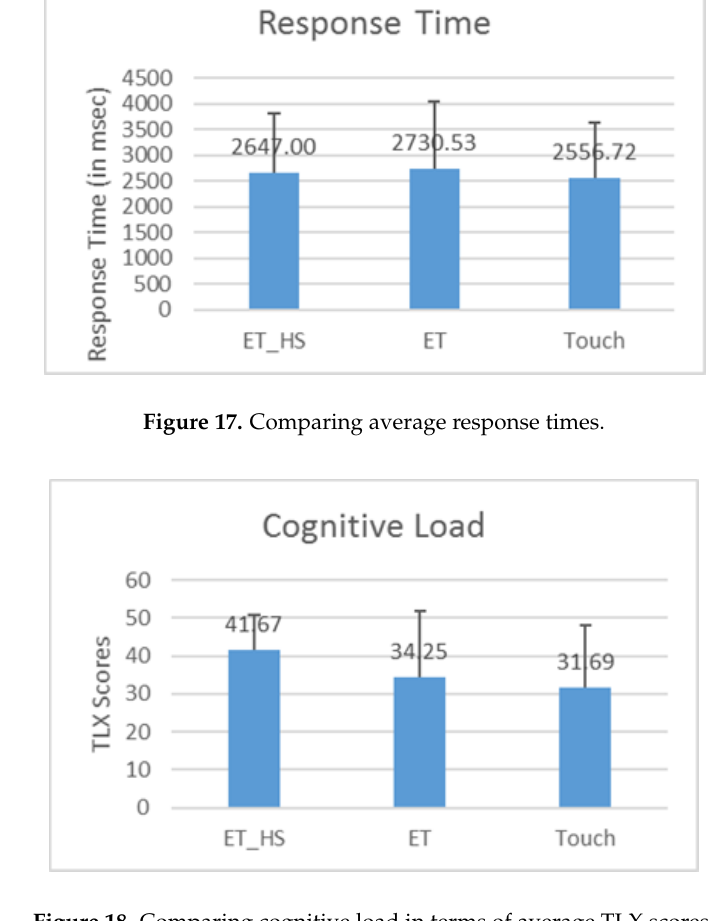
Figure 18. Comparing cognitive load in terms of average TLX scores.